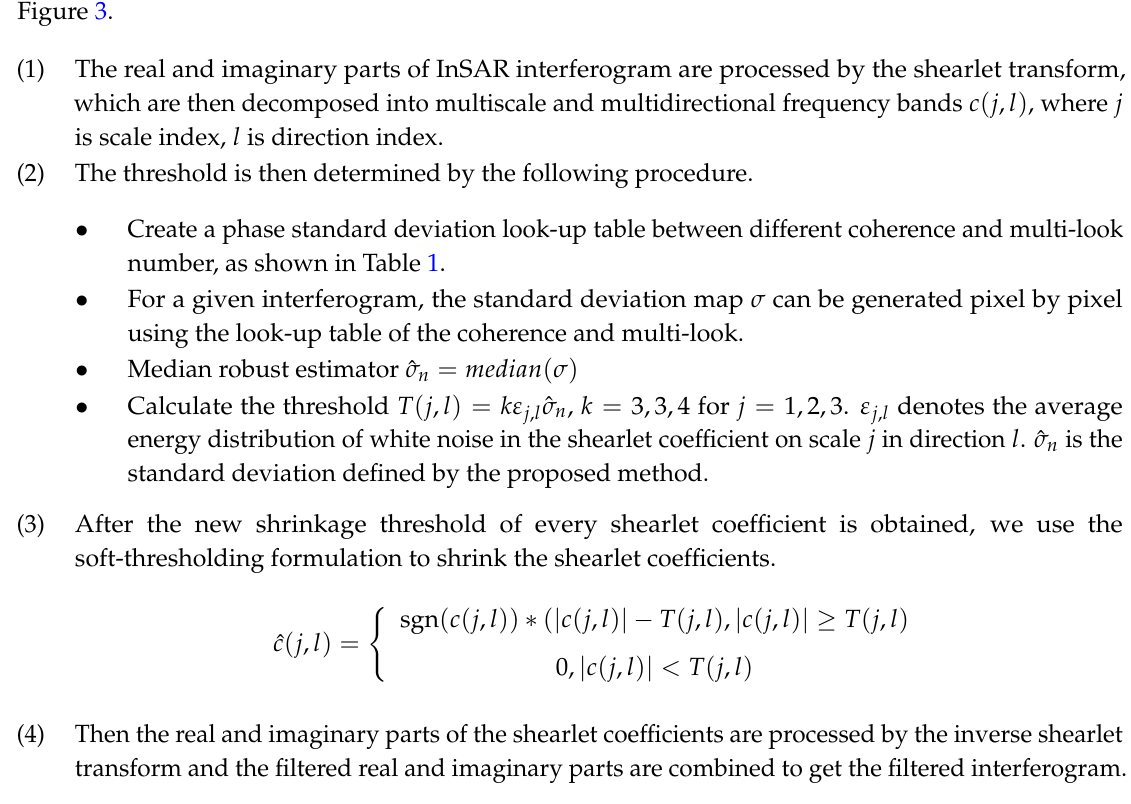
Table 1. Look-up table of phase standard deviations versus coherences and multi-look number. Coherence